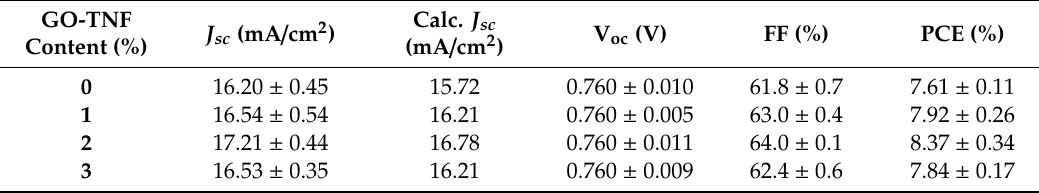
Table 1. Photovoltaic characteristics summary of the OSC devices based on PTB7:GO-TNF:PC 71 BM ternary blends a .